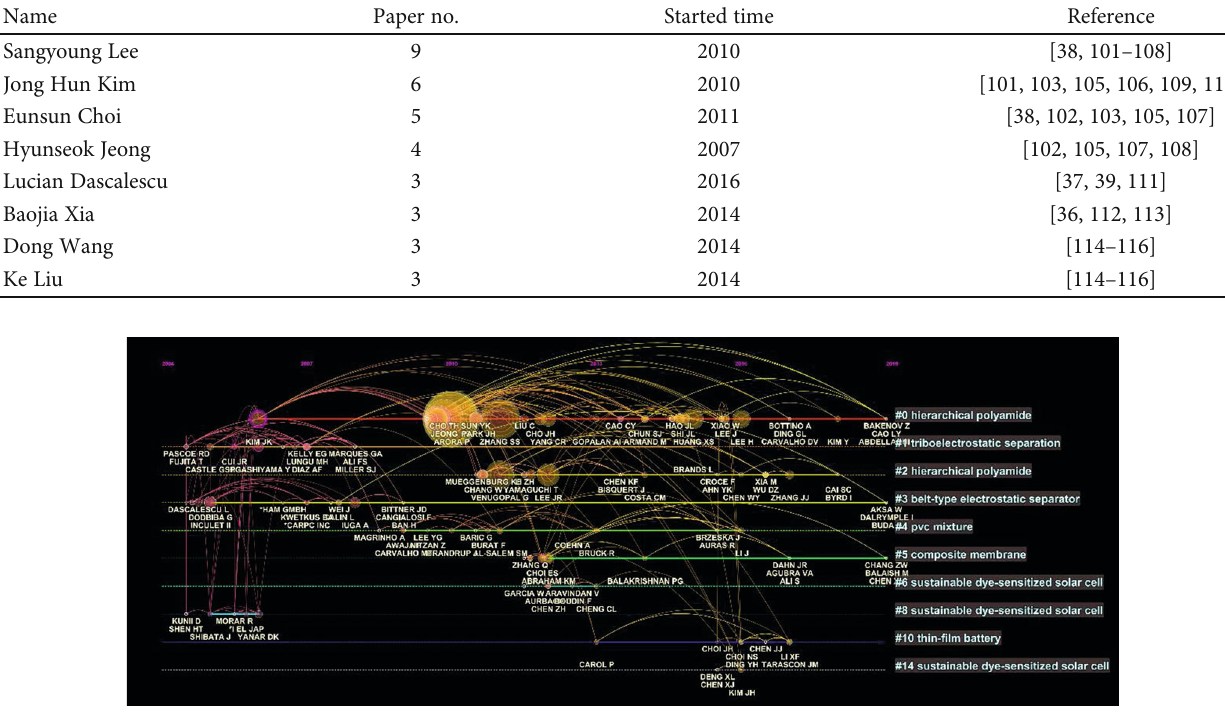
Figure 4: Timeline of author collaboration and topic clustering analysis.